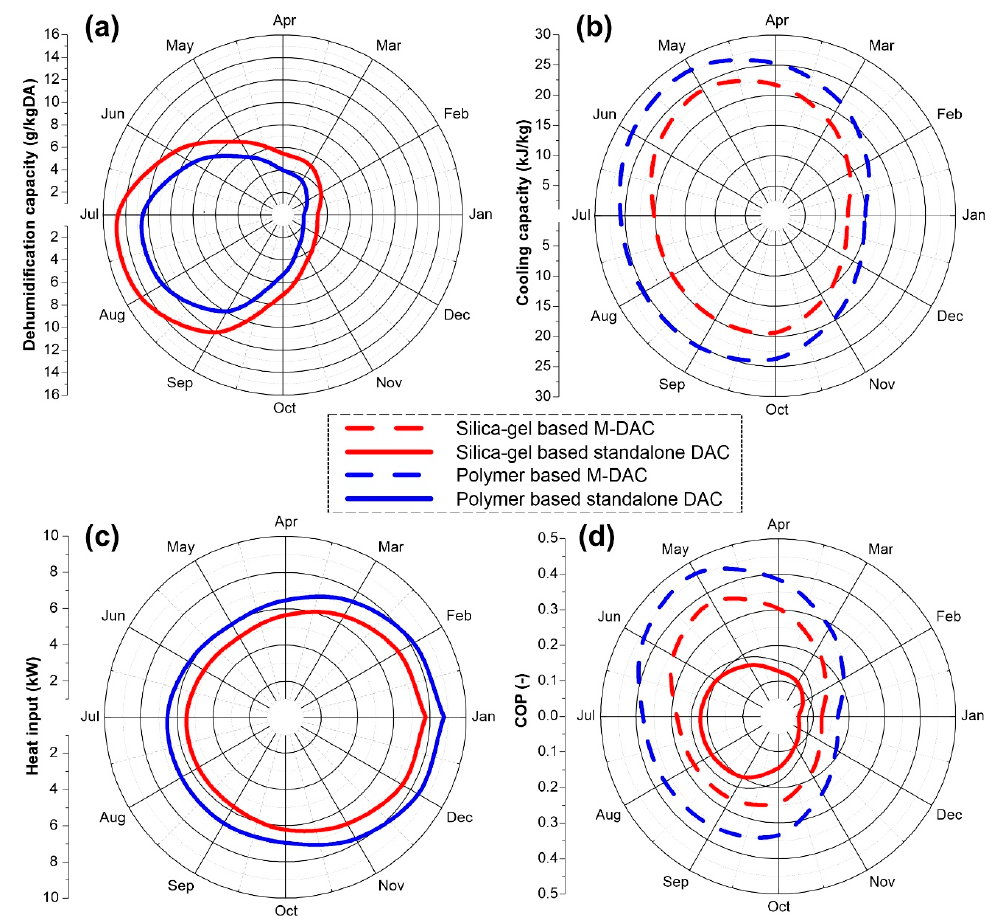
Figure 12. Monthly profile of ( a ) dehumidification capacity, ( b ) cooling capacity, ( c ) heat input, and ( d ) thermal COP for proposed AC systems.